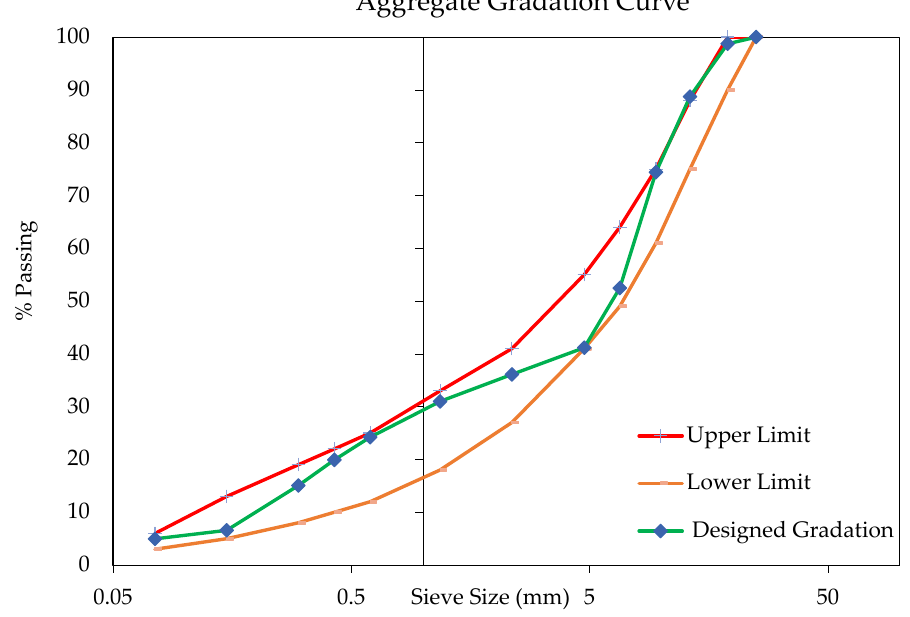
Figure 1. Combined aggregate gradation curve of the asphalt mixtures.